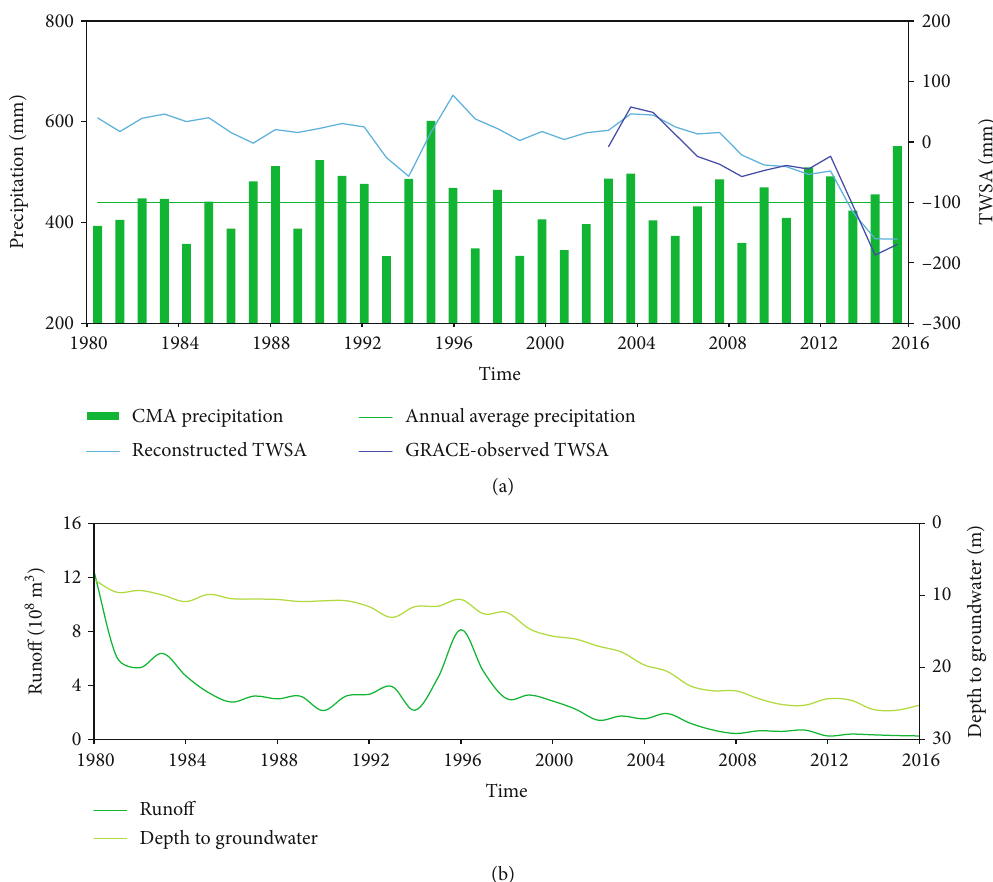
Figure 5: (a) The yearly time-series data of CMA precipitation, annual average precipitation, reconstructed TWSA, and GRACE-observed TWSA; (b) the yearly time-series data of average depth to groundwater in the Beijing Plain from historical document records and runo ff from the Guanting Reservoir.